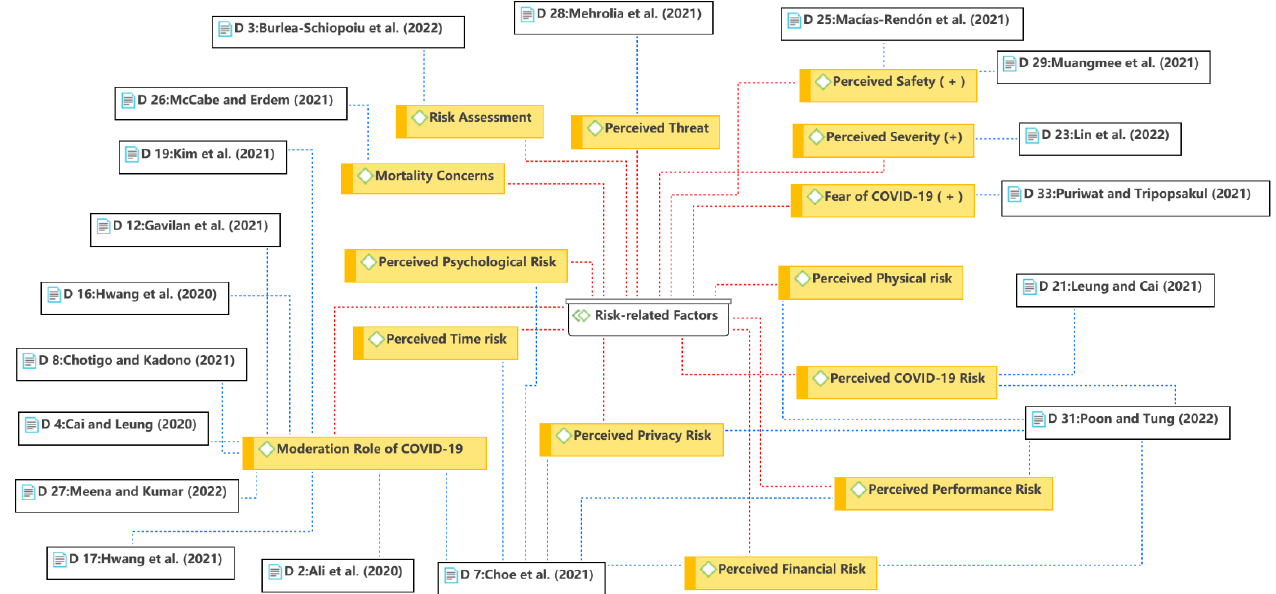
Figure 10. Theme 6: risk-related factors [9,13,15,23,26,28,34,35,37–39,44,48,52,54,56,59,60].